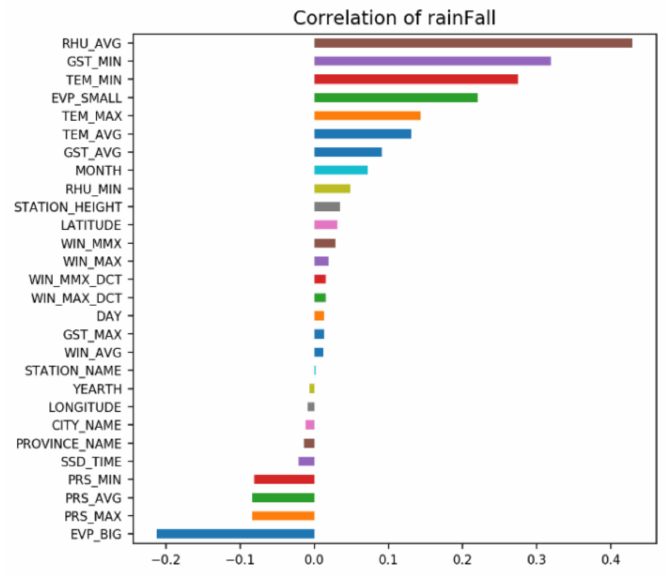
Figure 7. Correlation of each feature with the probability of